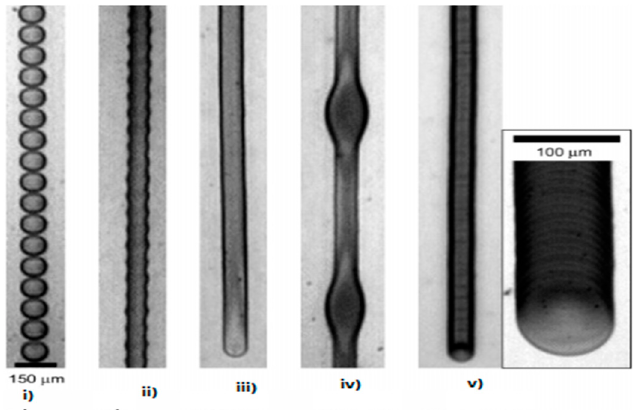
Figure 5. Samples of printed line characteristics: ( i ) single drops; ( ii ) scalloped; ( iii ) even; ( iv ) bulging; and ( v ) stacked coins. Reprinted with permission from [89].